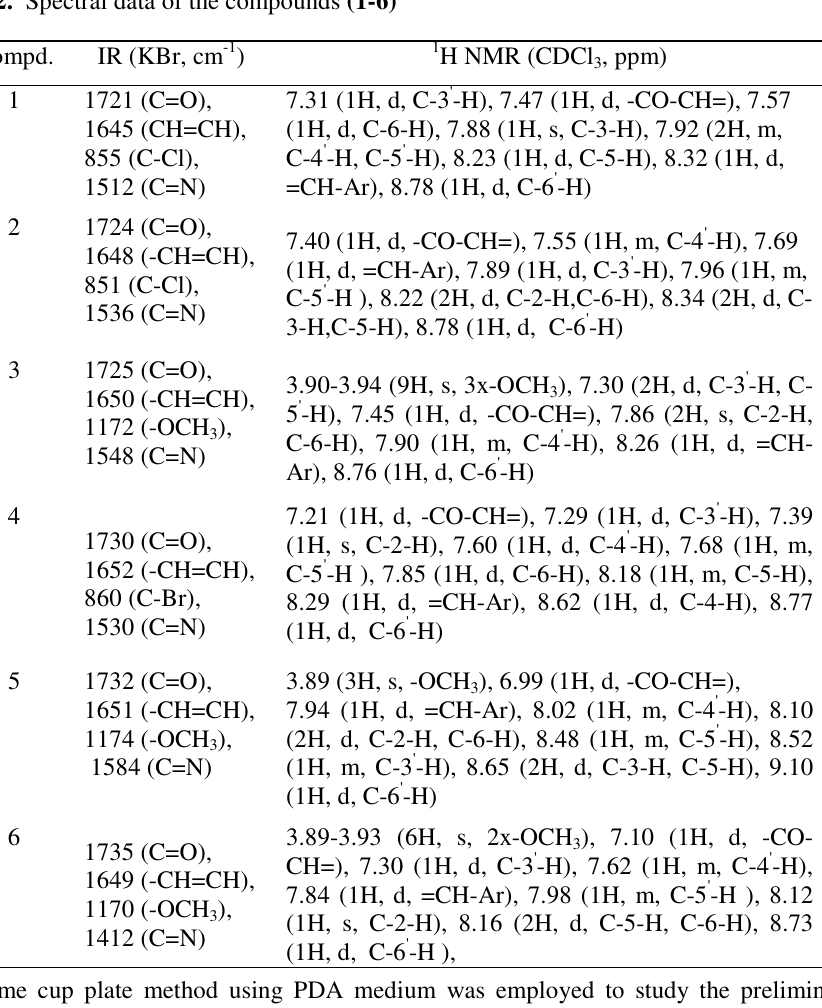
Table 2. Spectral data of the compounds